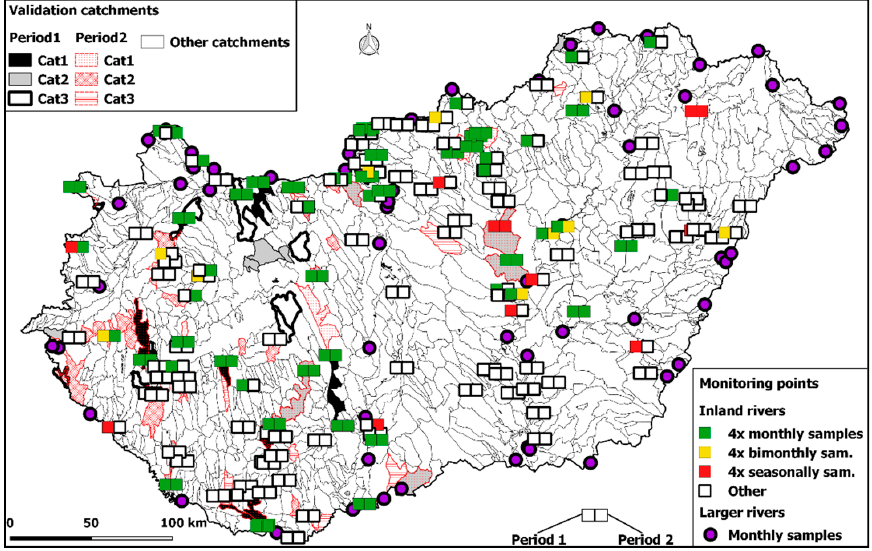
Figure 4. Surface water flow and quality monitoring stations.